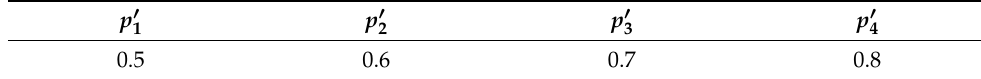
Table 2. Initial system’s state conditions of slave chaos